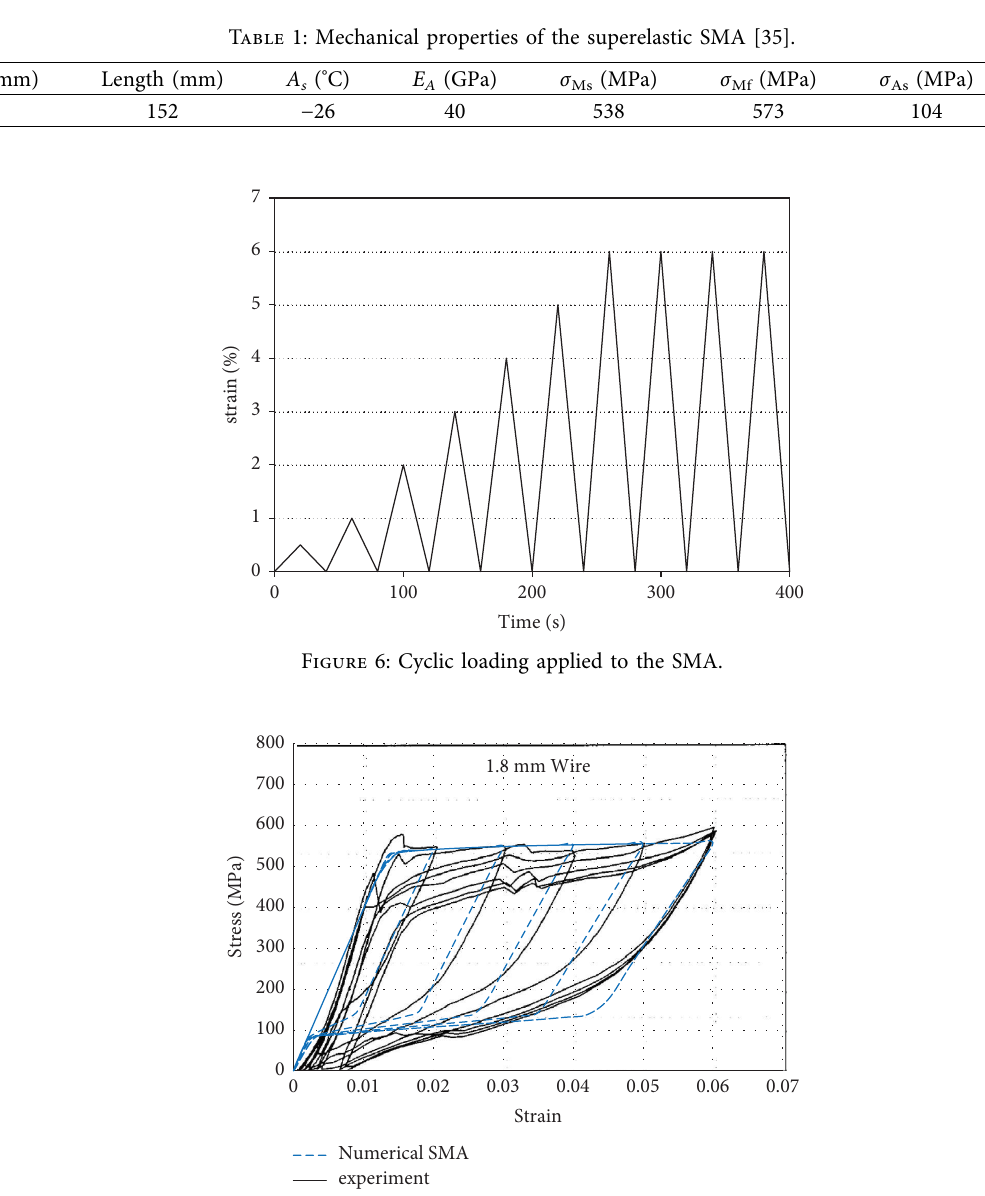
Figure 7: Te SMA superelastic behavior.